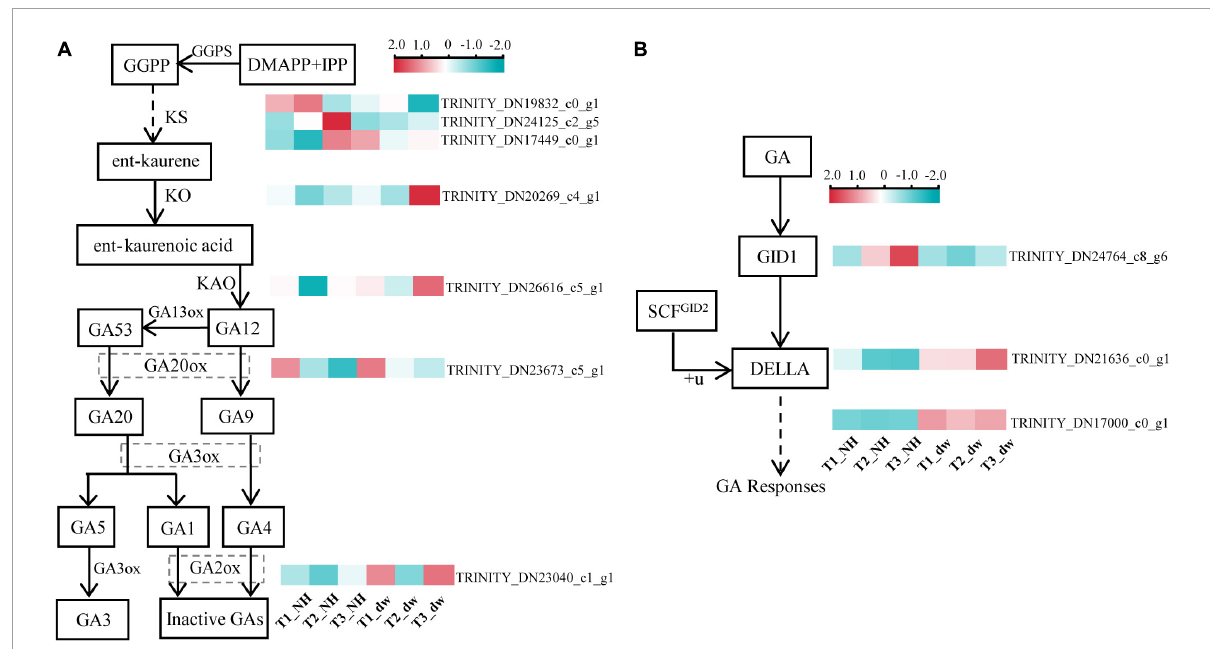
FIGURE4 Analysis of DEGs related to GA synthesis and signal pathways. (A) DEGs in the GA synthesis pathway. (B) DEGs in GA signaling pathway. GGPS, geranylgeranyl pyrophosphate synthase; KO, ent-kaurene oxidase; KAO, ent-kaurenoic acid oxidase; GA20ox, gibberellin 20 oxidase; GA2ox, gibberellin 2- β -dioxygenase; GID1, gibberellin Insensitive Dwarf1; GAI, gibberellin-acid Insensitive; GID2, gibberellin Insensitive